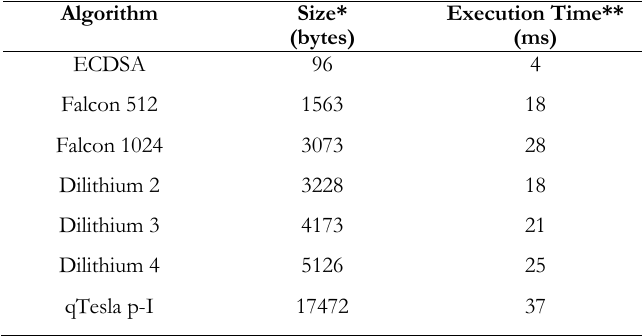
Table 2. Public keys and signature sizes of the algorithms [39]. Algorithm